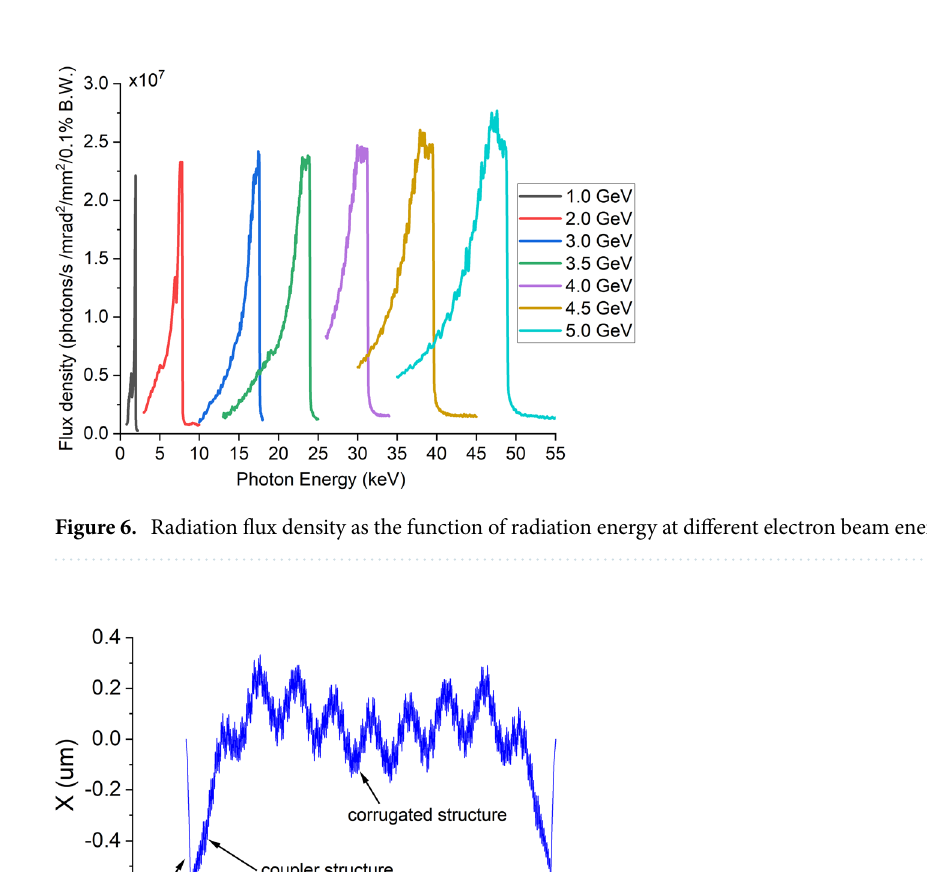
Table 3. Electron bunch parameters.